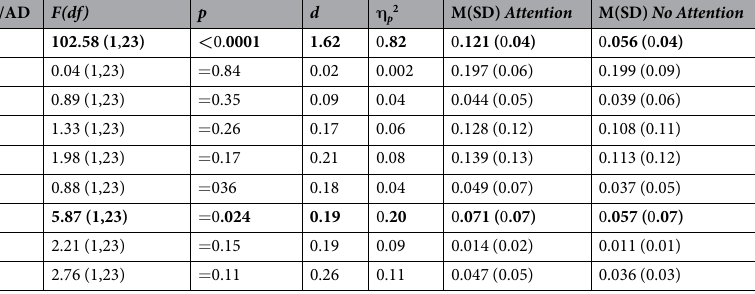
Table 1. AU unit activity as a function of attention or not for individual univariate ANOVAs Significant results in